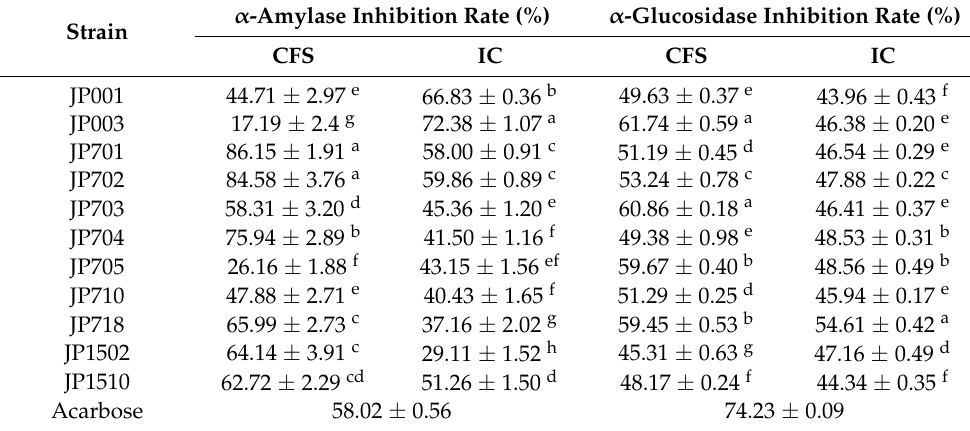
Table 8. Hypoglycemic ability of LAB